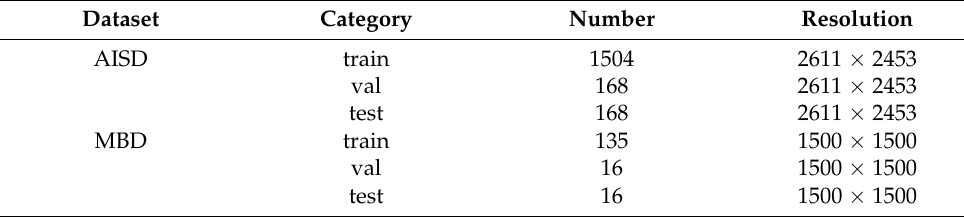
Figure 10. Samples of ( a ) the AISD, ( b ) the WHU dataset, and ( c ) the MBD. The division of datasets is shown in Table 1: Table 1. Datasets used in this paper.